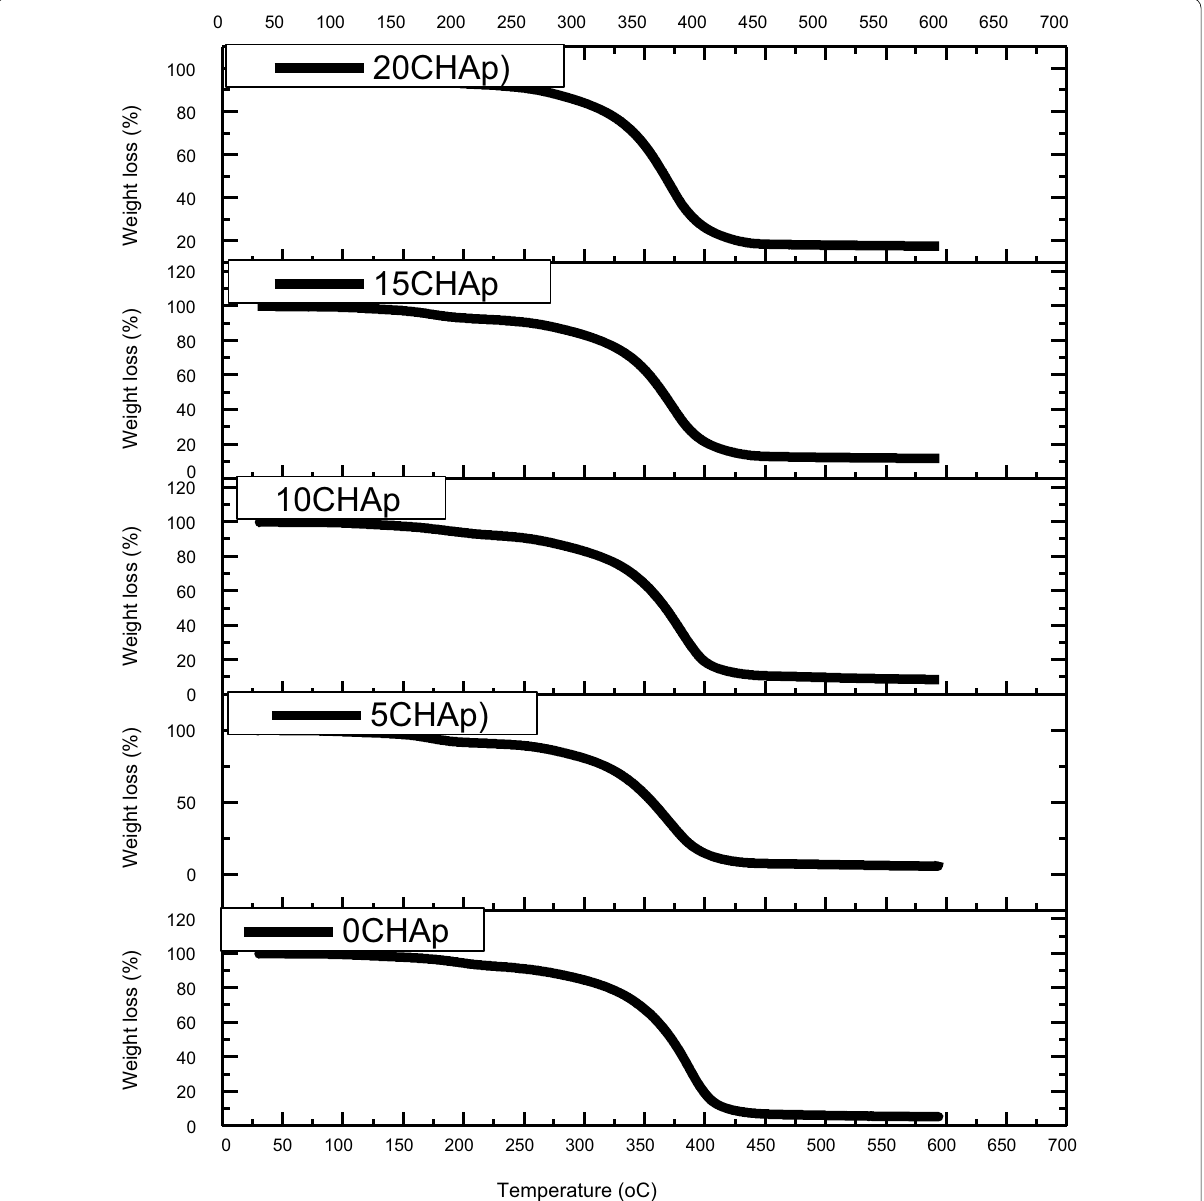
Fig. 7 Variation of percentage weight loss with temperature for composite produced with